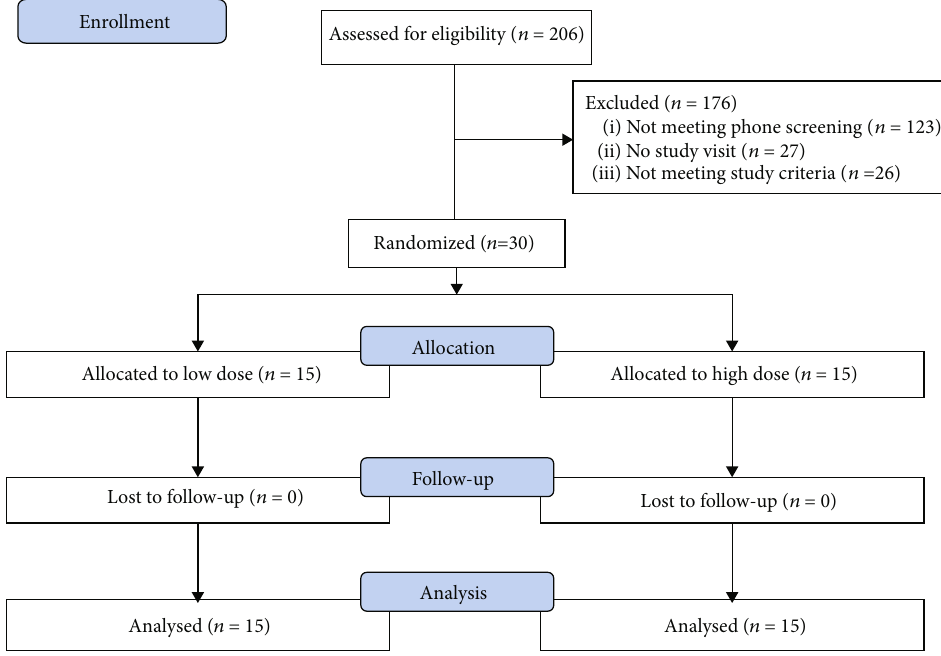
Figure 1: CONSORT